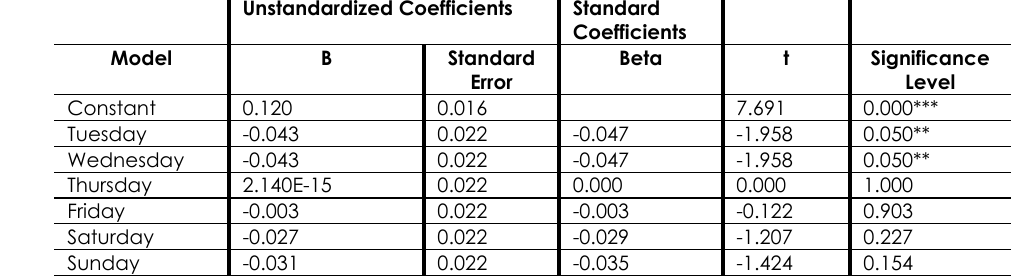
Table 8. Table of coefficients in the model established to determine whether there is a day effect on accidents.